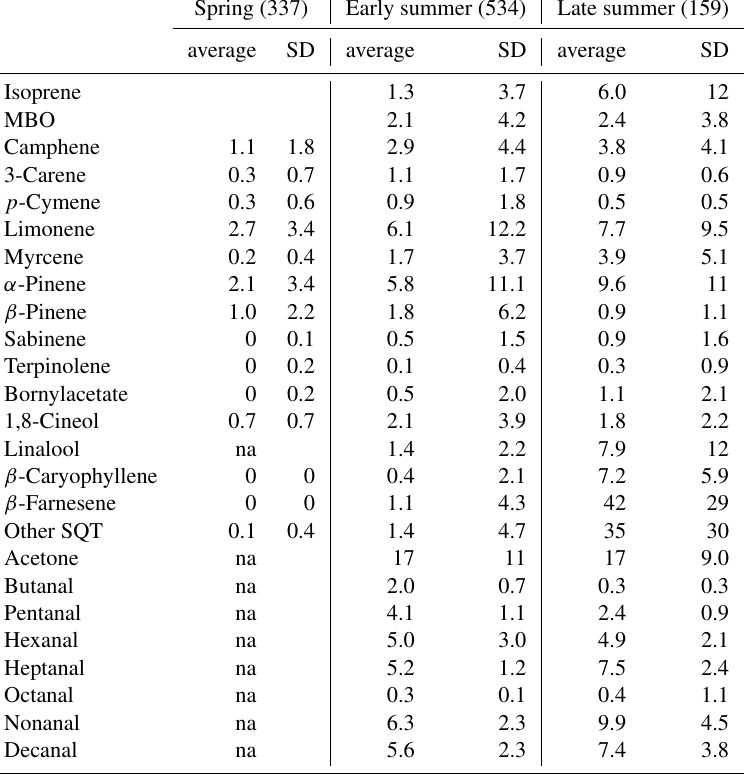
Table 3. Seasonal mean emission rates of isoprene, 2-methylbutenol (MBO), MT, SQT, acetone, and C 4 –C 10 carbonyls in ngg(dw) − 1 h − 1 . “na” means that the compounds were not included in the analysis. Spring is April–May, early summer 1.6–15.7, and late summer 16.7–31.8. bdl: below detection limit. Values are averages and standard deviations for the three measurement years (2011, 2014, 2015). Other SQT: sum of all other SQTs in emissions. The number of the measurements each season is in